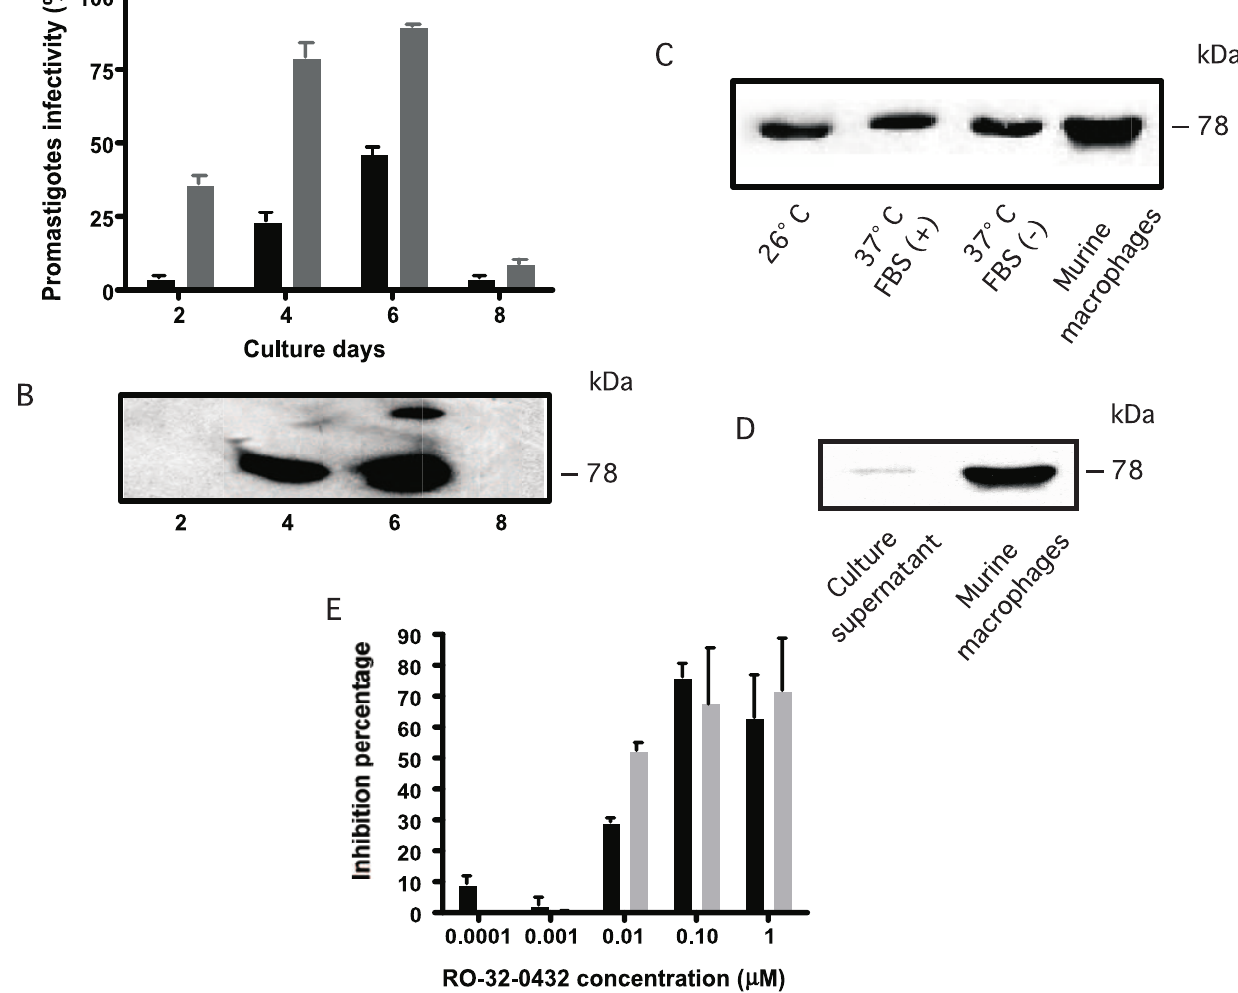
Figure 3. Implication of Leishmania PKC-like during macrophage internalization. (A): Internalization assay. Promastigotes at the 2 nd , 4 th , 6 th , and 8 th growth days were put in contact with adherent murine macrophages in a 2:1 parasite:macrophage ratio and incubated at 37 u C, 5% CO 2 for 18 hours. Cells were stained with May-Gru¨nwald-Giemsa and the number of infected macrophages ( black column ) and the parasite load ( gray column ) were calculated observing 100 macrophages/well. Results were expressed as the percentage of inhibition of these two parameters in comparison to the controls and were analyzed by using Student’s t -test. (B): Expression of parasite PKC during internalization into macrophages. The participation of PKC activity in the attachment step of internalization process was studied during L. mexicana proliferation by incubating promastigotes harvested at the 2 nd (middle log-growth phase), 4 th , 6 th , and 8 th culture days with adherent peritoneal macrophages. After a 3 hr contact period, promastigotes were harvested, lyzed and tested for PKC in a SDS-PAGE gel electrophoresis under native conditions using the monoclonal antibody directed to a consensus sequence of mammalian PKC a , b I , b II . (C): L. mexicana promastigotes at 4th growth day were incubated at 26 u C or 37 u C in absence or the presence of 10% FBS. (D): promastigotes were incubated only with the macrophages culture supernatant or with the macrophages during 3 hr before electrophoresis. (E): Effect of PKC inhibition on L. mexicana promastigote internalization. Stationary promastigotes of L. mexicana (2x10 6 cells/ ml) were pretreated for 1 hr with the selective PKC inhibitor (RO-32-0432) at different concentrations. After washes, promastigotes were added to 24- wells microplates containing adherent macrophages (parasite:macrophage ratio, 2:1). After 18 hour later macrophages were stained with May- Gru¨nwald-Giemsa. The number of infected macrophages ( black column ) and the parasite load ( gray column ) were calculated observing 100 macrophages/well. Results were expressed as the percentage of inhibition of these two parameters in comparison to the controls and were analyzed by Student’s t